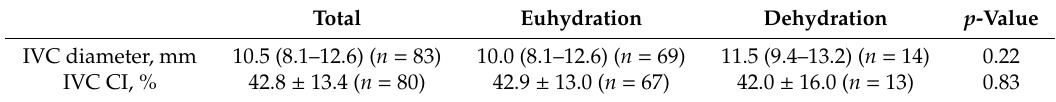
Table 4. IVC / IVC-CI di ff erences between euhydration and dehydration.